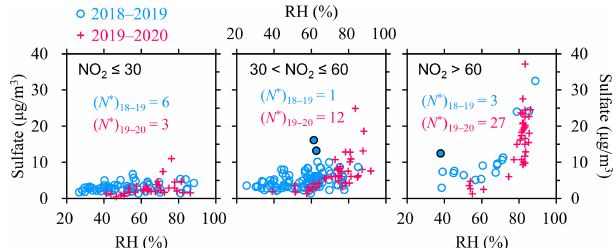
Figure 7. Dependences of sulfate on RH in different NO 2 ranges (below 30, 30–60 and above 60µg/m 3 ) . Results from the 2018– 2019 and 2019–2020 campaigns are shown using different mark- ers. The outliers in Fig. 5a are highlighted by the solid circles. N ∗ indicates the number of samples with RH above 80%. High-RH conditions were typically accompanied with NO 2 concentrations of below 30µg/m 3 during 2018–2019 and NO 2 above 60µg/m 3 during 2019–2020,